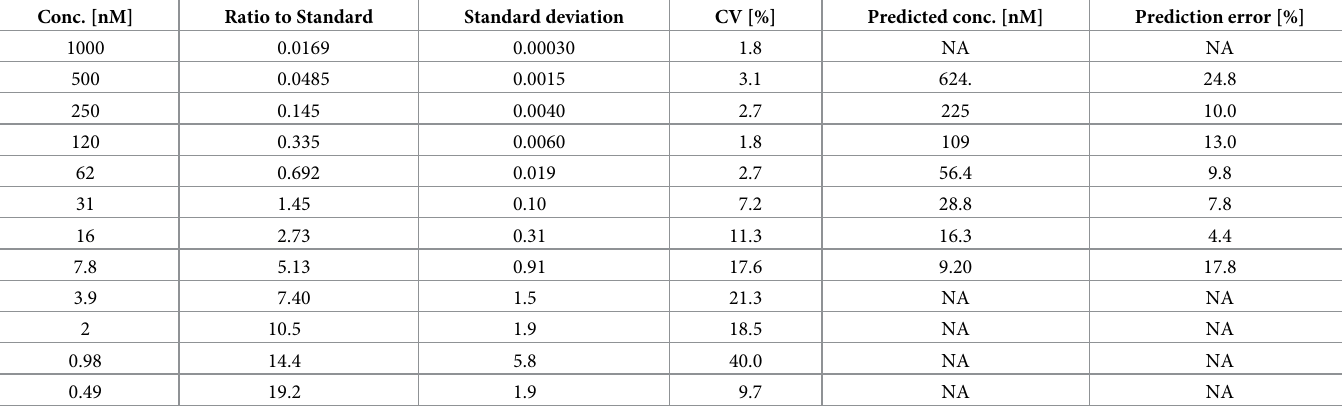
Table 2. Quantitative performance of EAQLLVIENEVCNHYK across a range between 490 fM to 1,000 nM in human plasma. Conc. [nM]